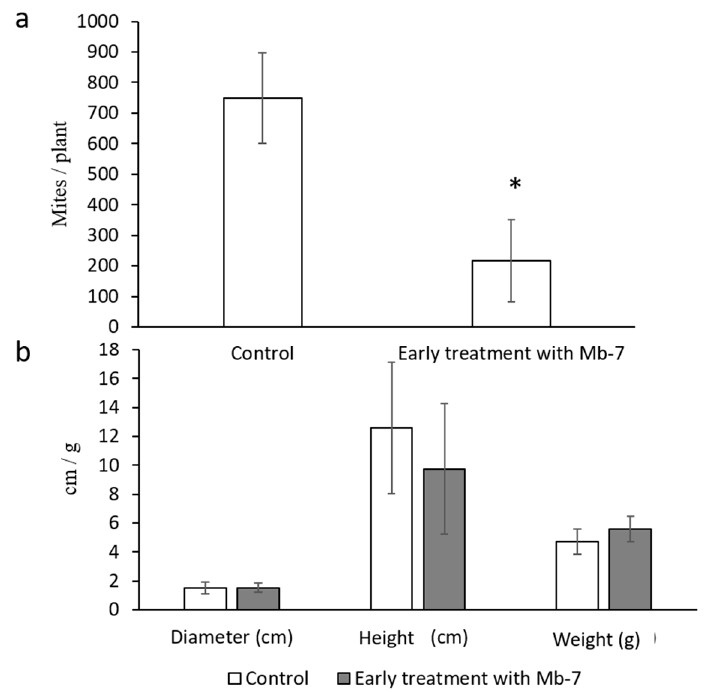
Figure 4. Effect of Mb7 (10 7 conidia mL − 1 ) on adult female Rhizoglyphus robini on potted onion plants. ( a ) Number of R. robini at 4 weeks after the start of the experiment on control plants and on plants that were treated with Mb7 conidia (* DF = 9, p = 0.0128). ( b ) Growth parameters of green onions. Numbers represent bulb diameter (cm), plant height (cm), or fresh plant weight (g). No significant differences were observed in all plant parameters.